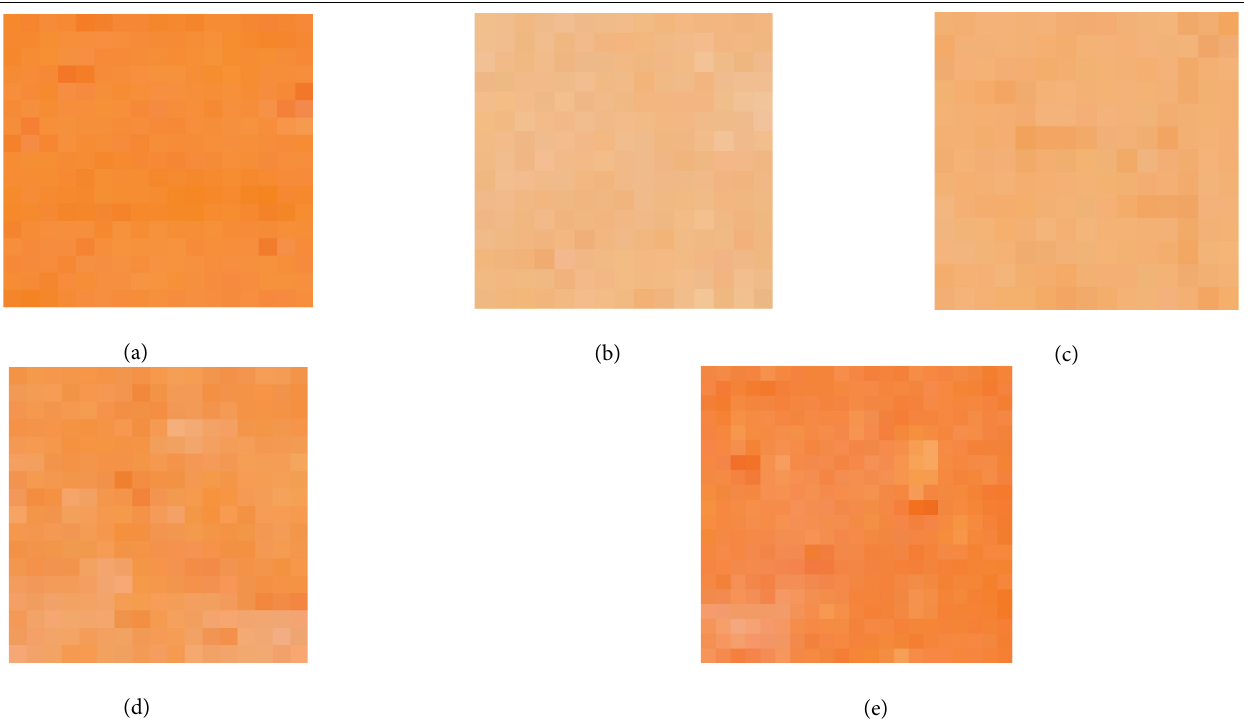
Data are presented as means ± SD (standard deviation). a–e Means in the same column with different superscripts are significantly different ( P < 0.05, Tukey’s HSD test). “-“ NBS Units of GS syrup reference sample, not subject to calculation. OF: oligofructose, TF: tapioca liquid fiber, ML: maltitol, and PM: chickpea- maize liquid